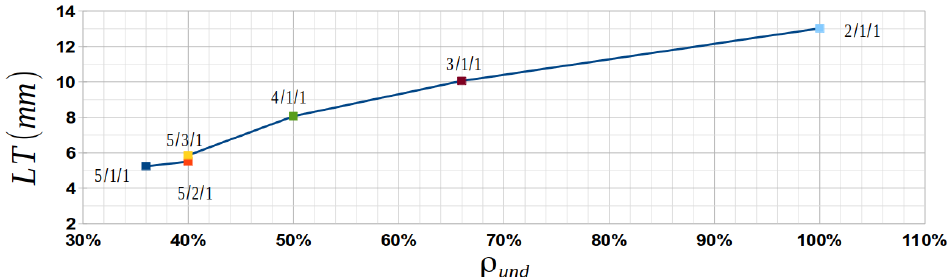
Figure 11. Variation in laminate thickness with undulation density.